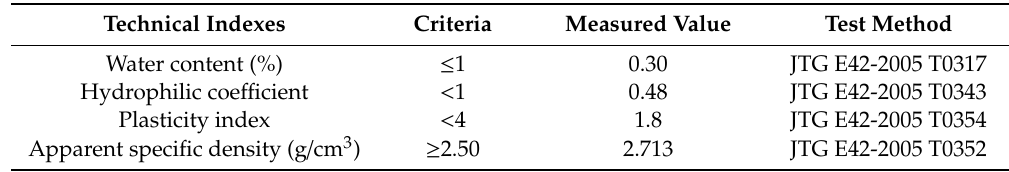
Table 6. Technical indexes of limestone powder.